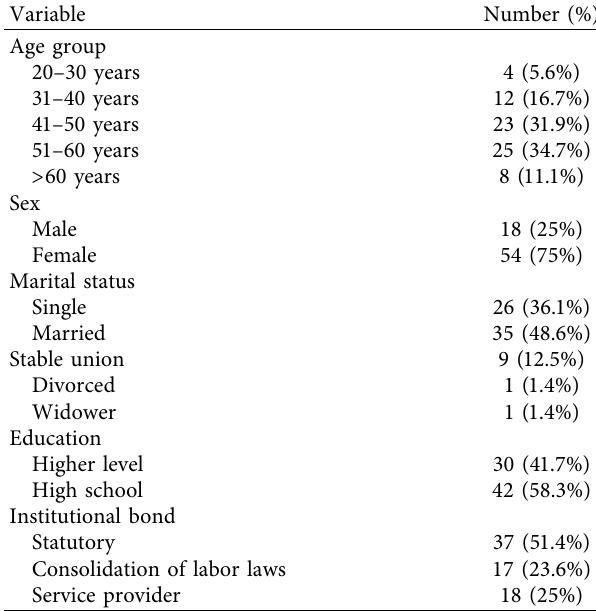
Table 1: Participants’ general characteristics ( n � 72).